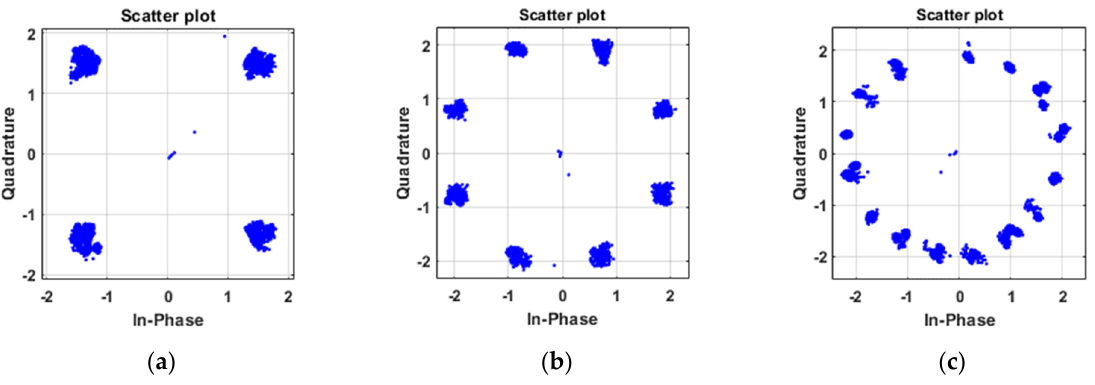
Figure 13. I/Q constellation shapes of ( a ) QPSK, ( b ) 8 PSK, and ( c ) 16 PSK.